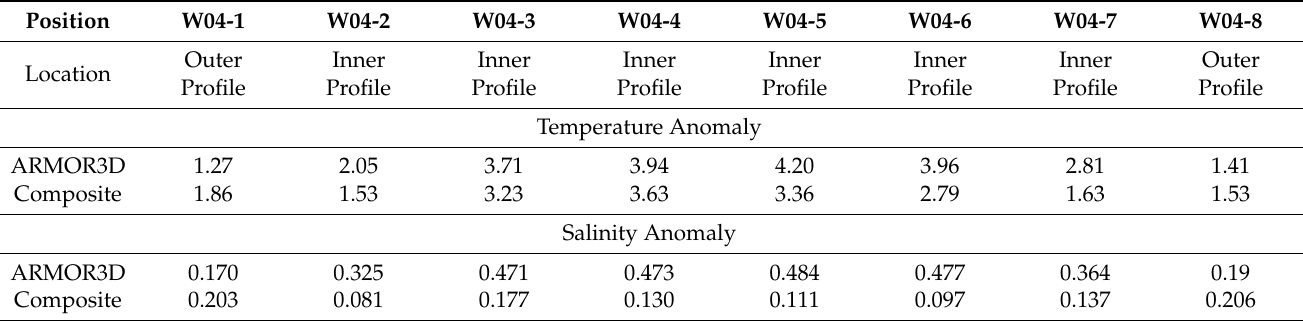
Table 2. Root mean square errors of temperature and salinity anomalies.